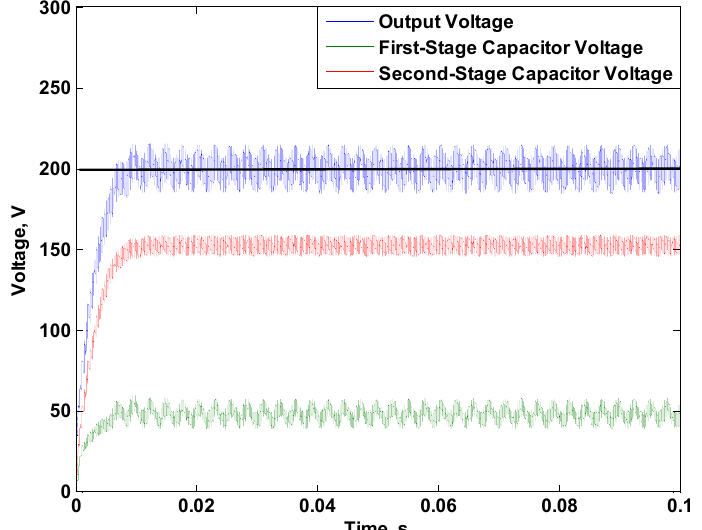
15 of 27 Figure 18. First-stage and second-stage inductor currents at a reference voltage of 200 V. Figure 19 shows the output, first-stage capacitor and second-stage capacitor voltages considering a failure in the first-stage source when the reference voltage is set at 200 V. This failure is simulated by considering the voltage of the first-stage voltage being re-